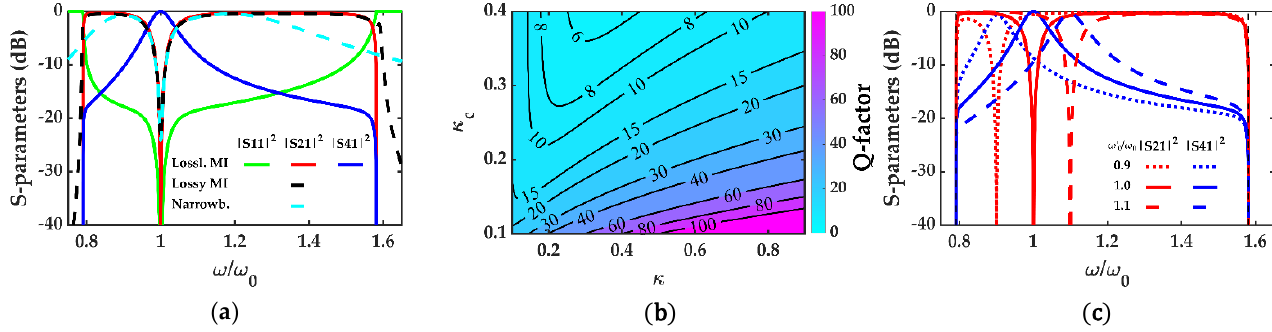
Figure 3. MI directional filter performance for κ = 0.6 and κ c = 0.3 : ( a ) scattering parameters for lossless and lossy ( Q = 200 ) resonators with MI terminations (1) and real narrowband terminations (2); ( b ) variation of Q bp with κ and κ c for a lossless filter with MI terminations (1); ( c ) scattering parameters for lossless resonators with MI terminations (1) for ω 0′ /𝜔 0 = 0.9, 1.0,and 1.1 .